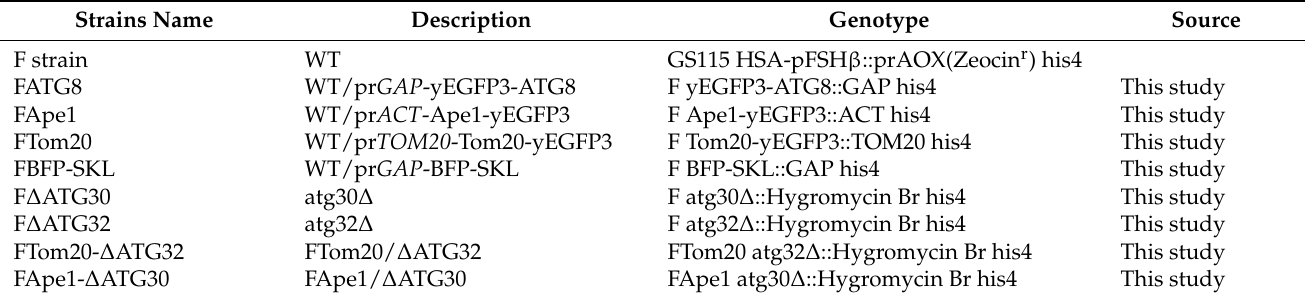
Table 1. Recombinant strains of Pichia pastoris in this